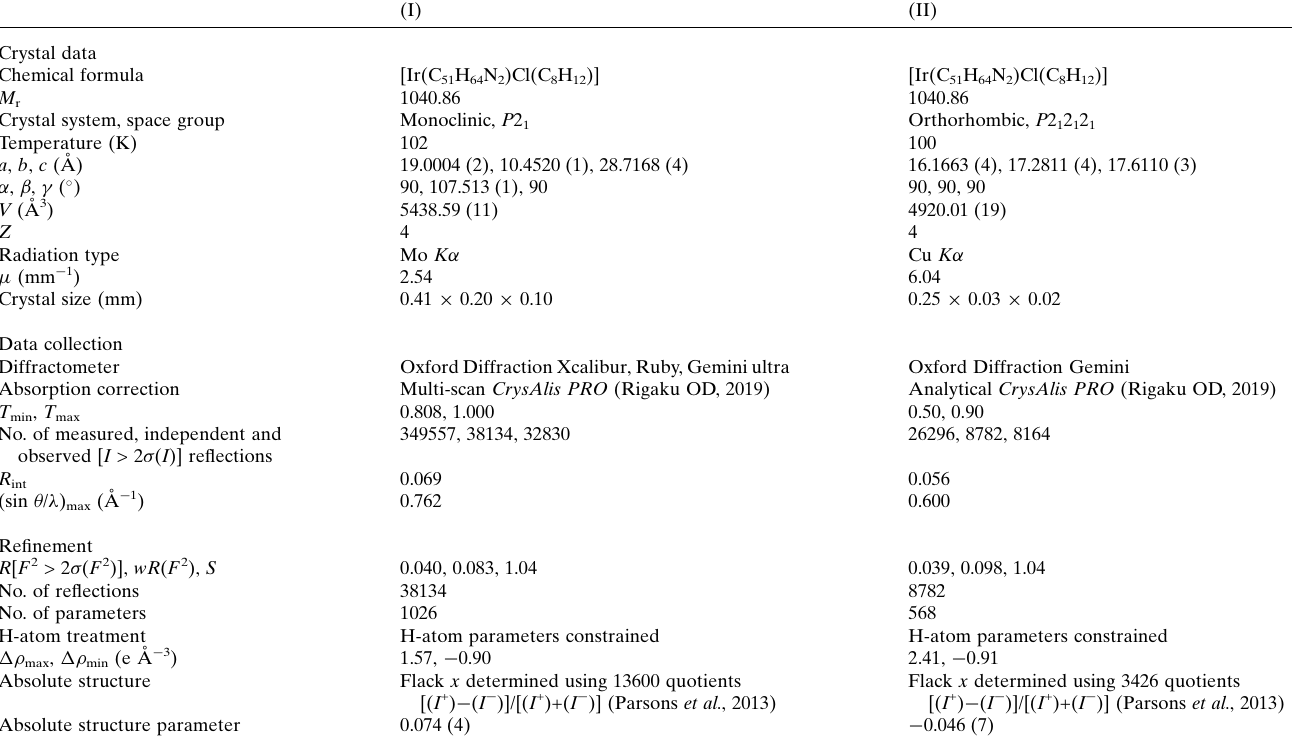
Table 2 Experimental